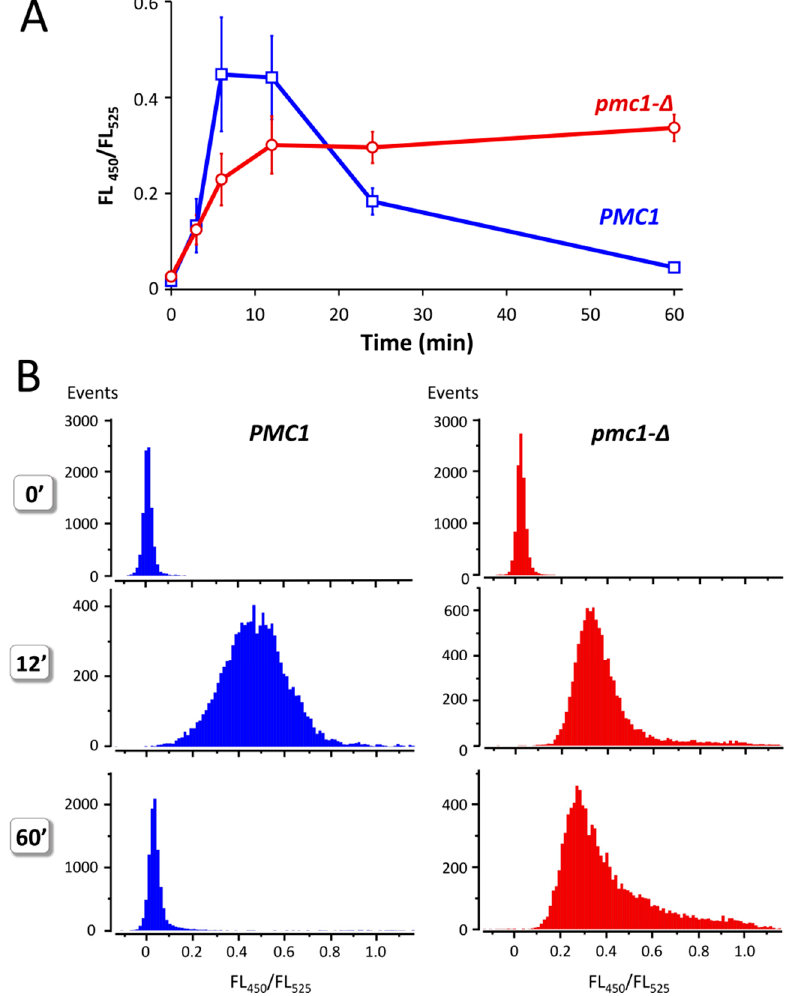
Figure 4. Effect of Ca 2+ concentration rise in culture medium on the ratio between fluorescence at 450 nm and 525 nm (FL 450 /FL 525 ) excited by 405 nm laser in individual cells of strains DL5 ( PMC1 ) and DL5-pmc1 ( pmc1- Δ ) producing GEM-GECO. Overnight YP-Suc cultures were 3-fold diluted with fresh YP-Suc medium, grown for 6 h. The obtained cultures were diluted 120-fold with YP-Suc medium supplemented with 100 mM CaCl 2 . Fluorescence in individual cells was measured using flowcytometry after 3 ′ , 6 ′ , 12 ′ and 60 ′ incubation. The 0 ′ samples are represented by the same cultures, which were diluted by YP-Suc without the CaCl 2 supplement. ( A ), Dynamics of FL 450 /FL 525 median values during incubation with 100 mM CaCl 2 in the culture medium. Mean values of medians with standard deviations of these means were calculated using data from five and six independent replicates in the pmc1- Δ mutant and wild-type strain, respectively. ( B ), distribution of cells with noted FL 450 /FL 525 values in cultures before (0 ′ ) and after 12 ′ and 60 ′ incubation in the culture medium supplemented with 100 mM CaCl 2 .